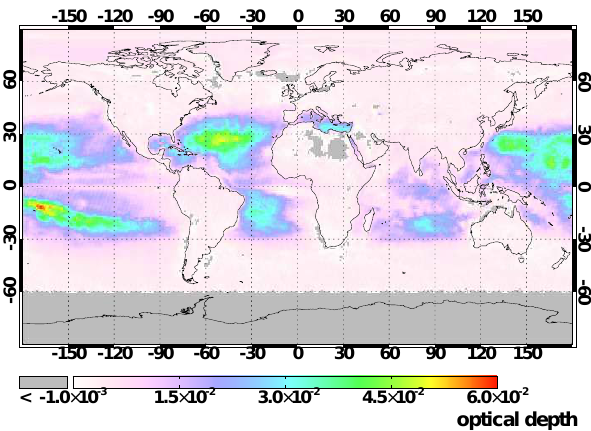
Figure 10. Retrieved liquid water optical depth at 460nm for July